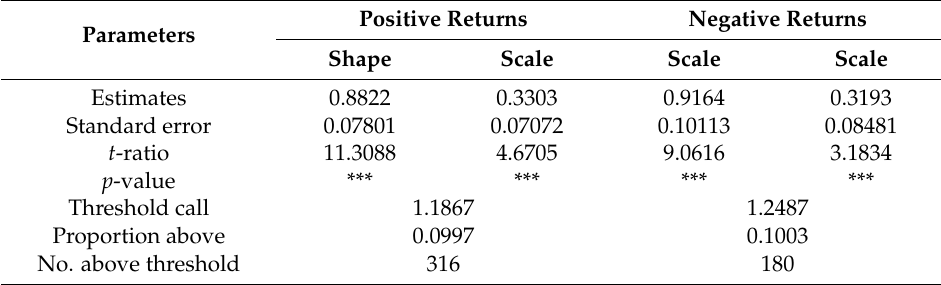
Table 10. Peak-over-threshold (POT) distribution parameter estimates of GSE.